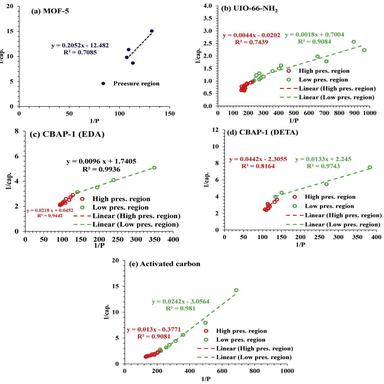
Linearized Langmuir isotherm model fit for the tested adsorbents.